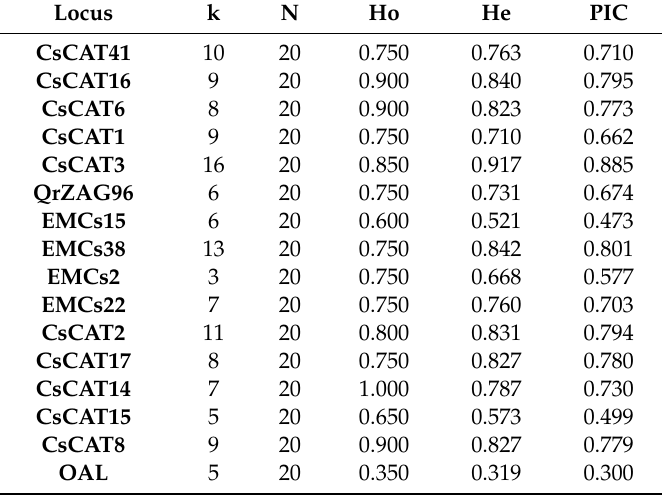
Table 1. The number of individuals (N), the number of alleles (k), the observed (Ho) and expected (He) heterozygosity and the polymorphic information content (PIC) are reported for each SSR locus in C. sativa